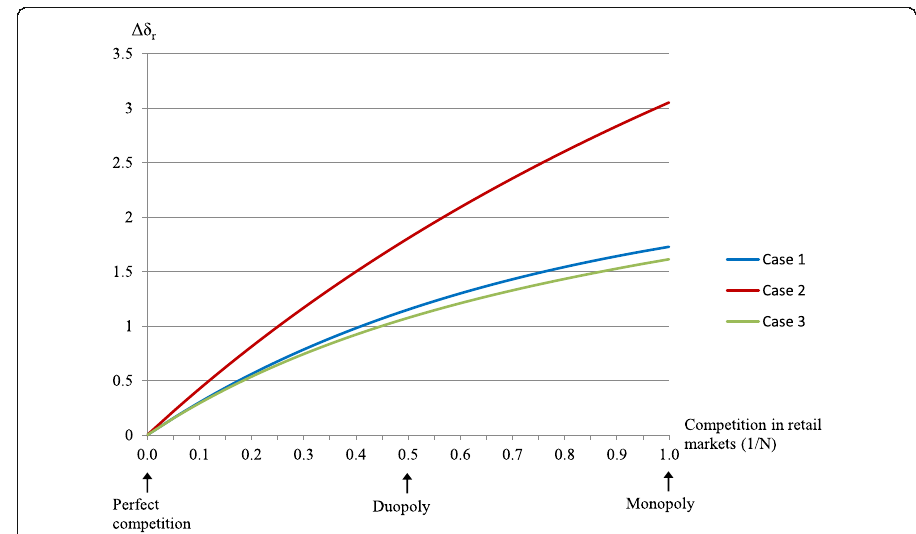
Fig. 2 The increase ( Δ δ r ) in retailers ’ profit margin due to the weakened buyer power in agricultural procurement under various levels of seller power in retail markets. Note: Δ δ r is the increase in retailers ’ profit margin when processors ’ buyer power is weakened from M = 2 to M = 3. The increase ( Δ δ r ) is larger when retailers have stronger seller power in retail markets. Case 1 is when there is a competitive wholesale market. Case 2 is when there is an oligopoly wholesale market. Case 3 is when there is an oligopsony wholesale market. Retailers ’ profit margin increase in case 2 (red line) is larger than that in case 1 (blue line). The relative magnitudes between retailers ’ profit margin increase in case 3 and those in cases 1 and 2 depend on various market factors so that all (in)equalities between them are